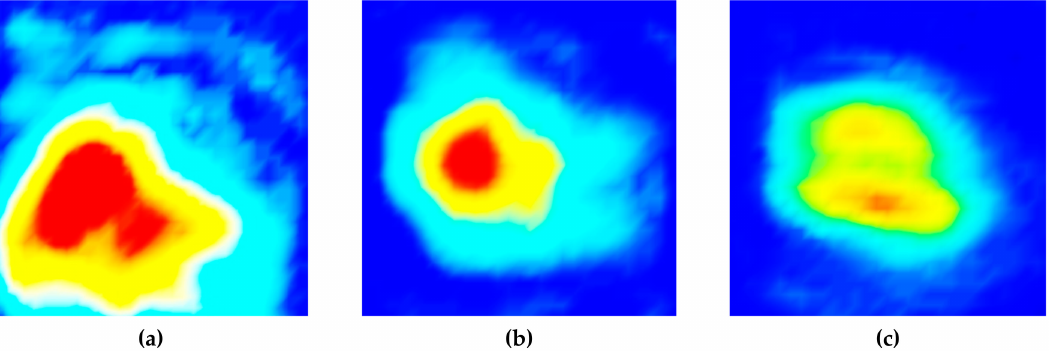
Figure 9. Ultrasonic images acquired by scanning the ( a ) top, ( b ) front, and ( c ) side of a weld-metal specimen using the through-transmission